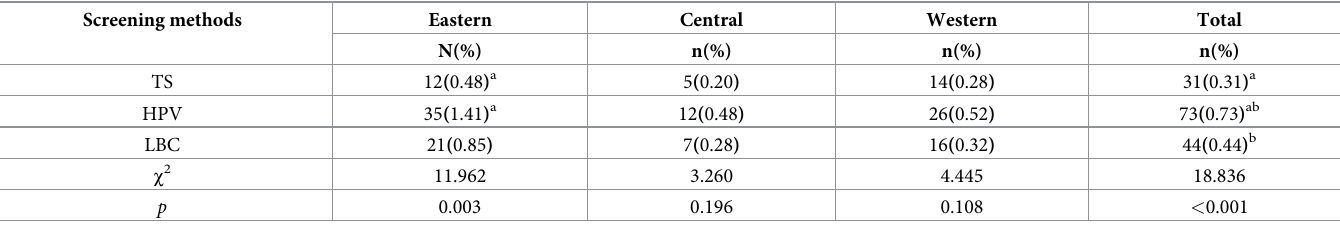
a indicates a statistically significant difference between TS and HPV groups, p < 0.017 b indicates a statistically significant difference between HPV and LBC groups, p <